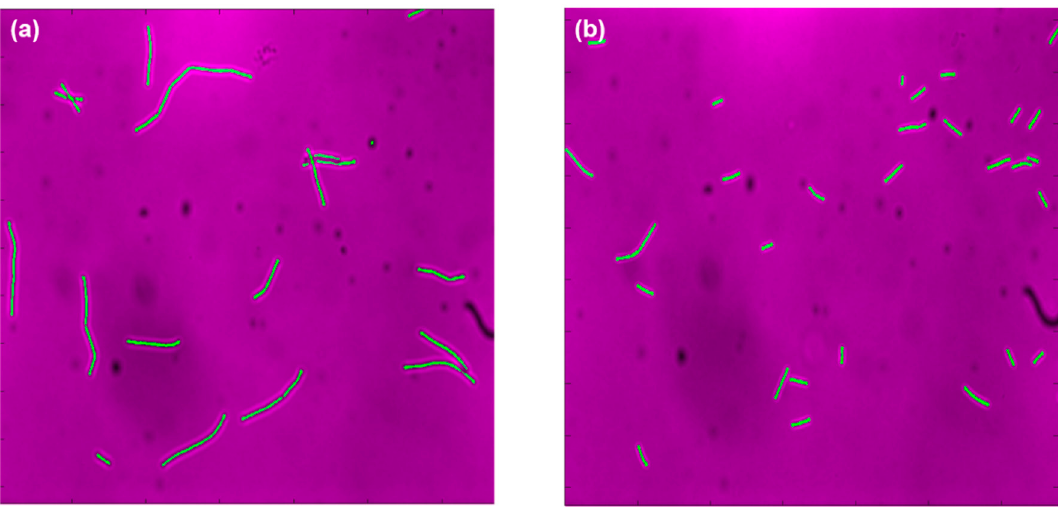
Figure 3. Microscopic images (false color) for 10th hour sample taken from ( a ) pH-A and ( b ) pH-B. Table 1. Statistical moments for cell area (in pixels) extracted from microscopic and automated images of final-hour fermentation samples from pH-A and pH-B. Microscope Automated Imaging pH-A